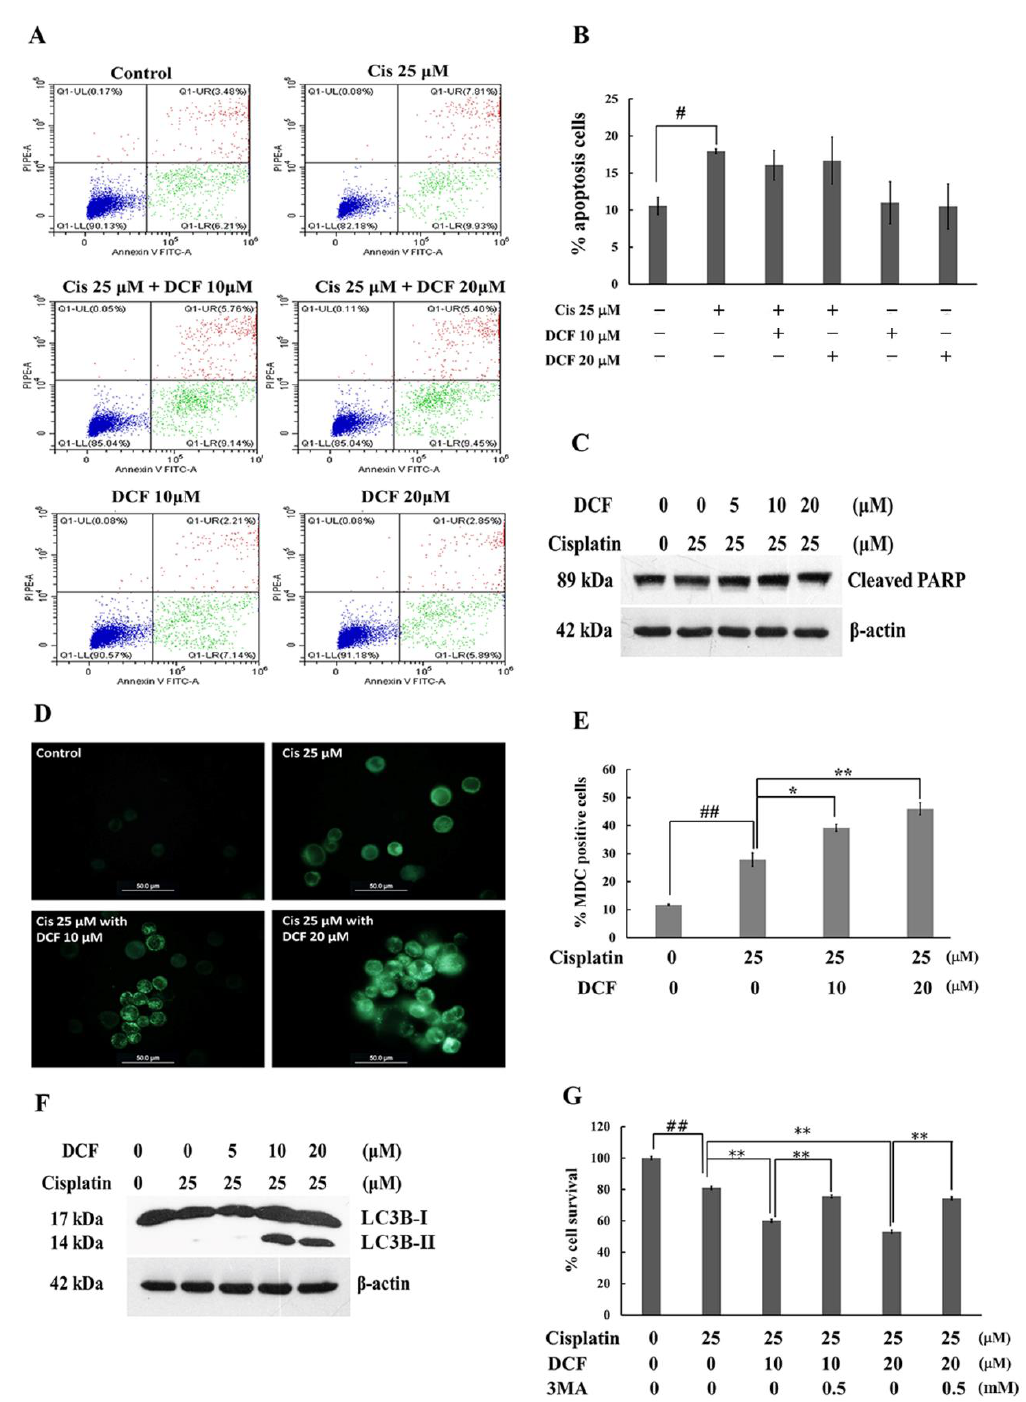
Figure 2. DCF in combination with cisplatin induced KATO/DDP cells death via autophagy pathway. The KATO/DDP cells were treated with cisplatin alone or cisplatin in combination with DCF at 10 or 20 µM for 24 h, at 37 °C. The apoptosis cells were detected by using annexin V and PI staining and analyzed by flow cytometer ( A ). Graphical representation of percentage of apoptosis cells ( B ). The combination effect of DCF and cisplatin on the expression of cleaved PARP in KATO/DDP cells was examined by Western blot analysis ( C ). Autophagy vacuoles formation was detected by label- ling with MDC dye and detected under fluorescent microscope ( D ) and percentage of autophagy vacuoles was quantified and represent in bar graph ( E ). KATO/DDP cells were treated with cisplatin